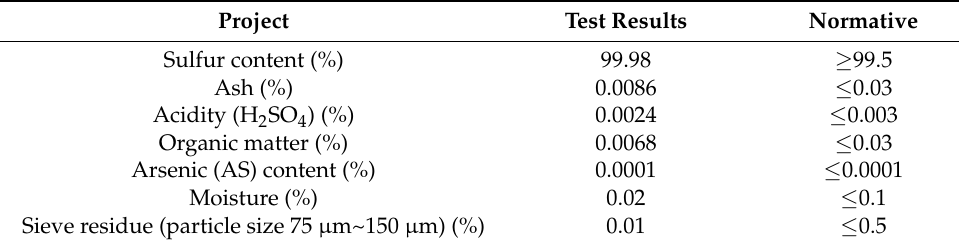
Table 4. Technical specifications of sulfur